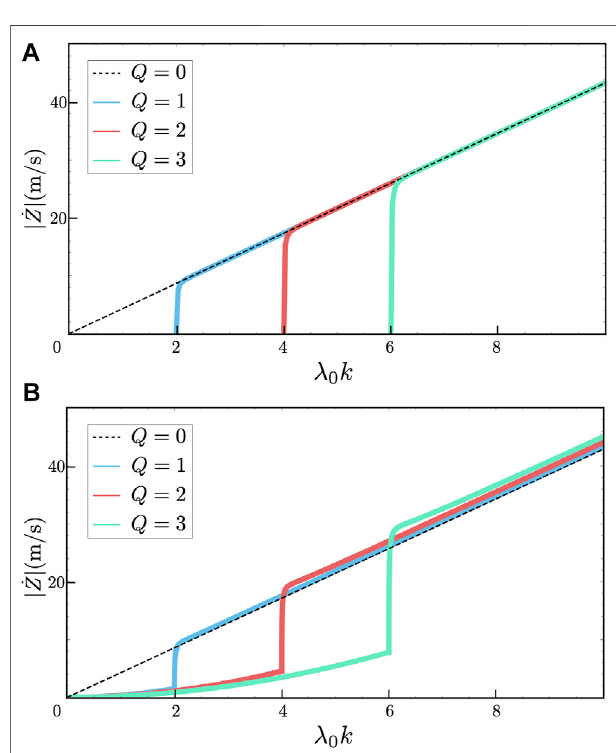
FIGURE 6 | Domain-wall velocity _ Z as a function of wavenumber λ 0 k in the (A) absenceofthedamping α =0andinthe (B) presenceofthedamping α = 0.1. The dashed line represents the domain-wall velocity without considering re fl ection which is equivalent to the case of Q = 0. The blue (red, green) line is the velocity ( Eq. 43 ) with Q = 1 ( Q = 2, Q = 3).